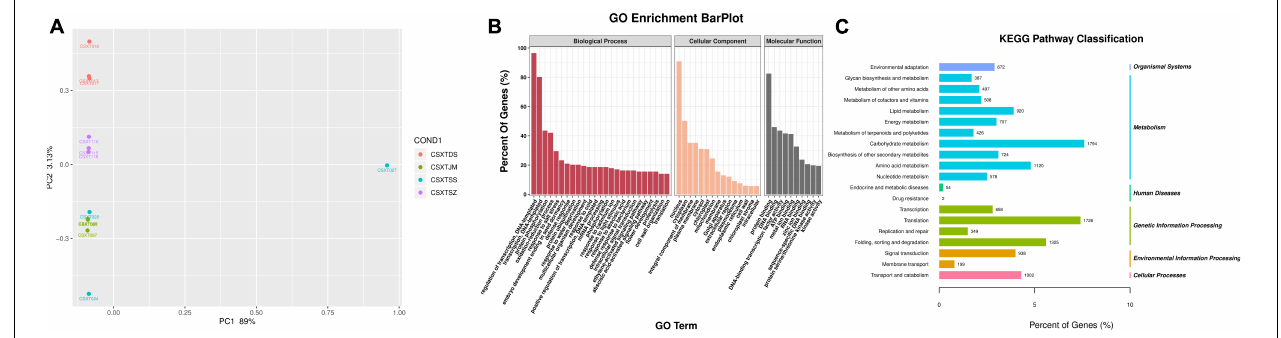
FIGURE 2 | Transcriptome sequencing results. (A) PCA map of sample differential genes; (B) GO functional annotation map of genes; and (C) KEGG transcriptome annotation results.